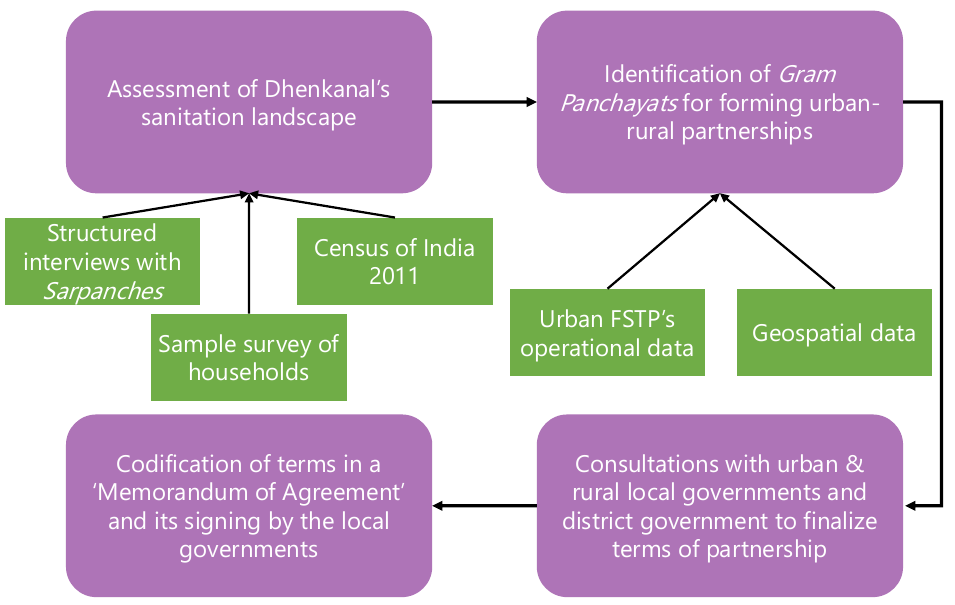
Figure 2. Process of developing the urban–rural partnership.